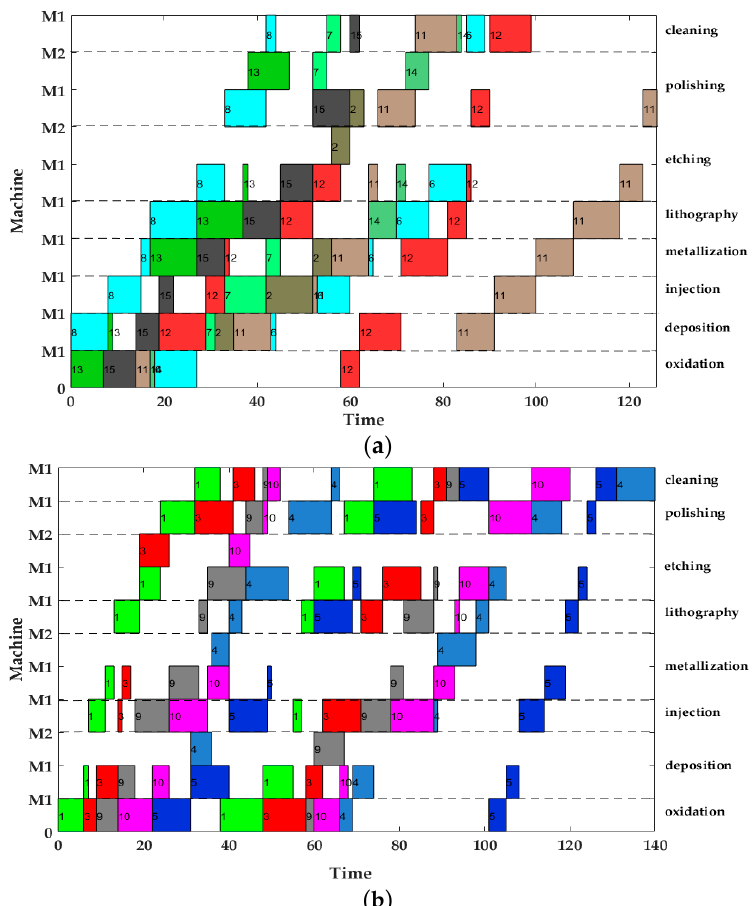
Figure 8. Scheduling Gantt charts of jobs processed in two factories. ( a ) Factory 1. ( b ) Factory 2.